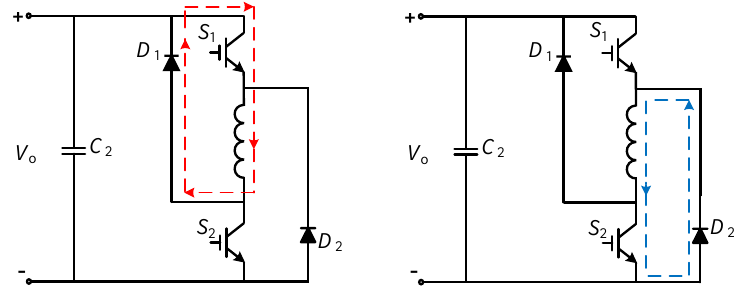
Figure 6. Zero-voltage loop.